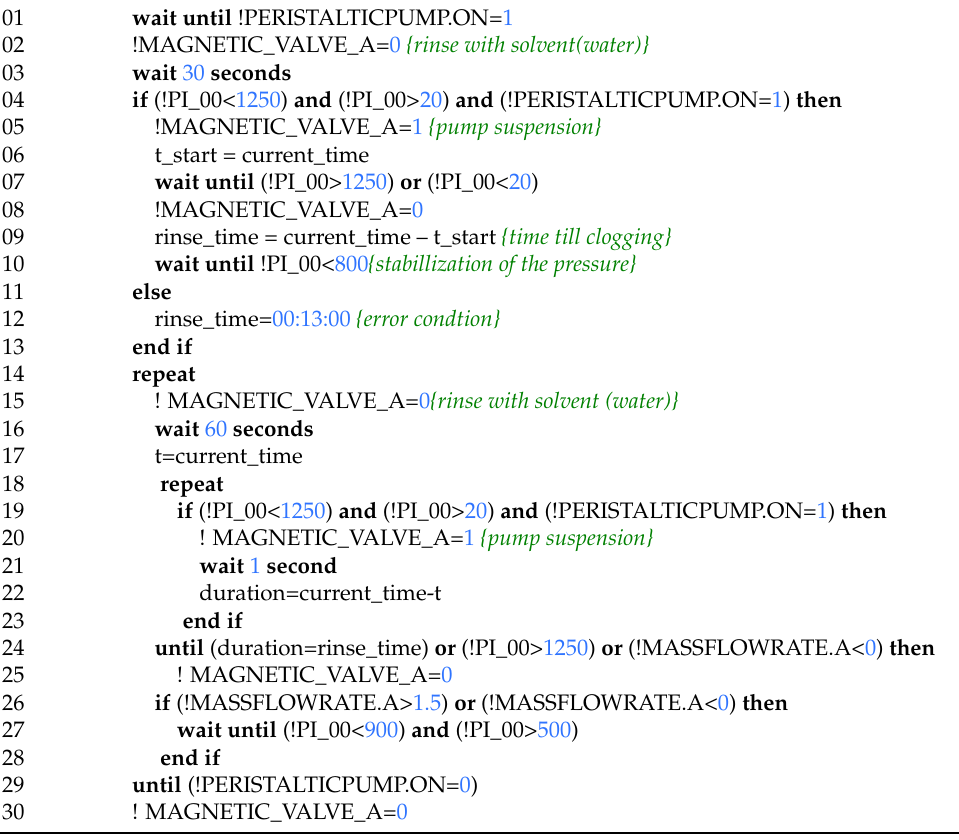
Table A5. HiText™ rinsing code for “pressure loss rinse” translated from German to English. 01 wait until